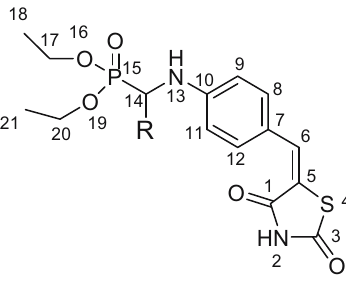
Figure 3: General structure of title compounds 8a – j